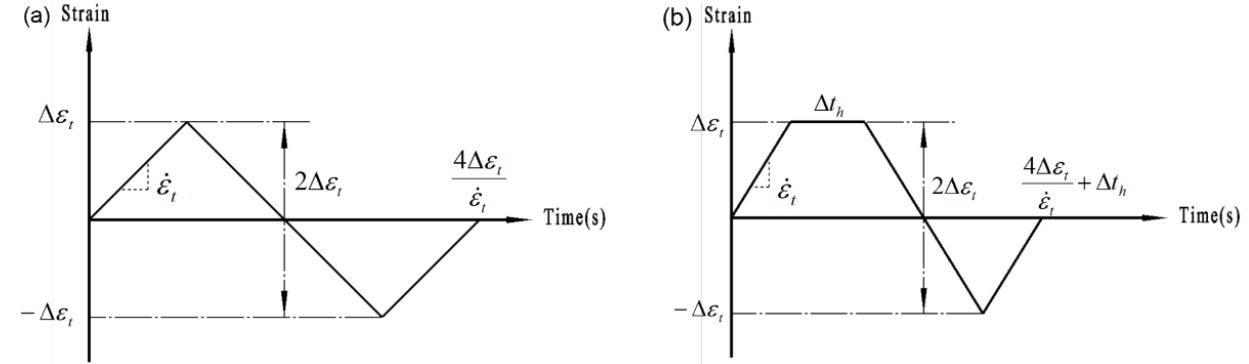
Figure 3. Schematic loading process: ( a ) continuous LCF and ( b ) LCF with tensile holding. Table 2. Experimental details for all LCF tests.